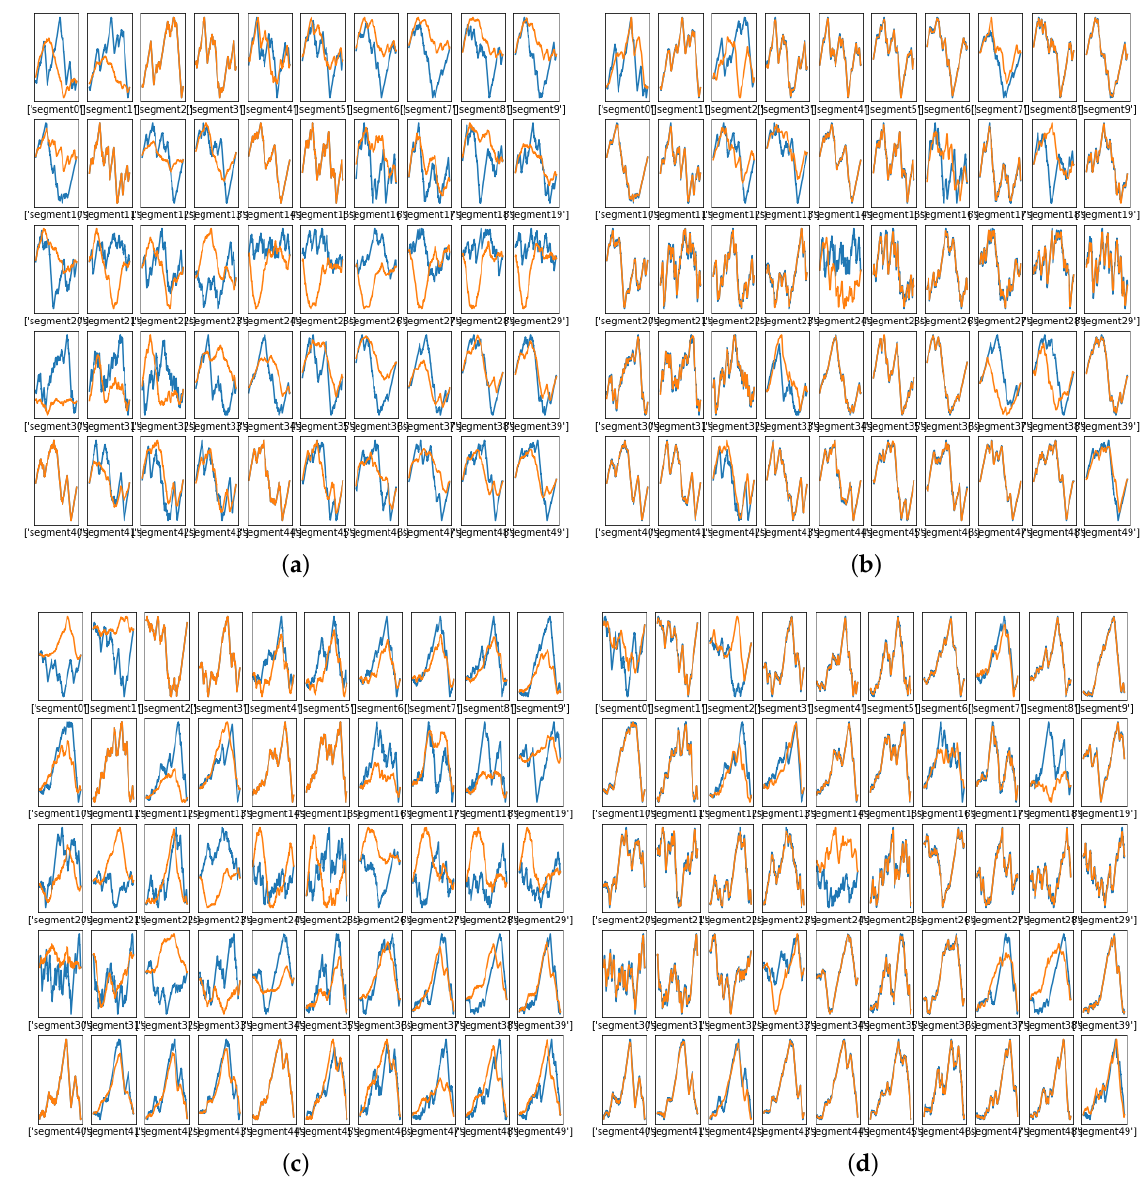
Figure 12. Learned warping path a , Phase Two. ( a ) Warping path a , 2500 iterations. ( b ) Warping path a , 10,000 iterations. ( c ) Warping path b , 2500 iterations ( d ) Warping path b , 10,000